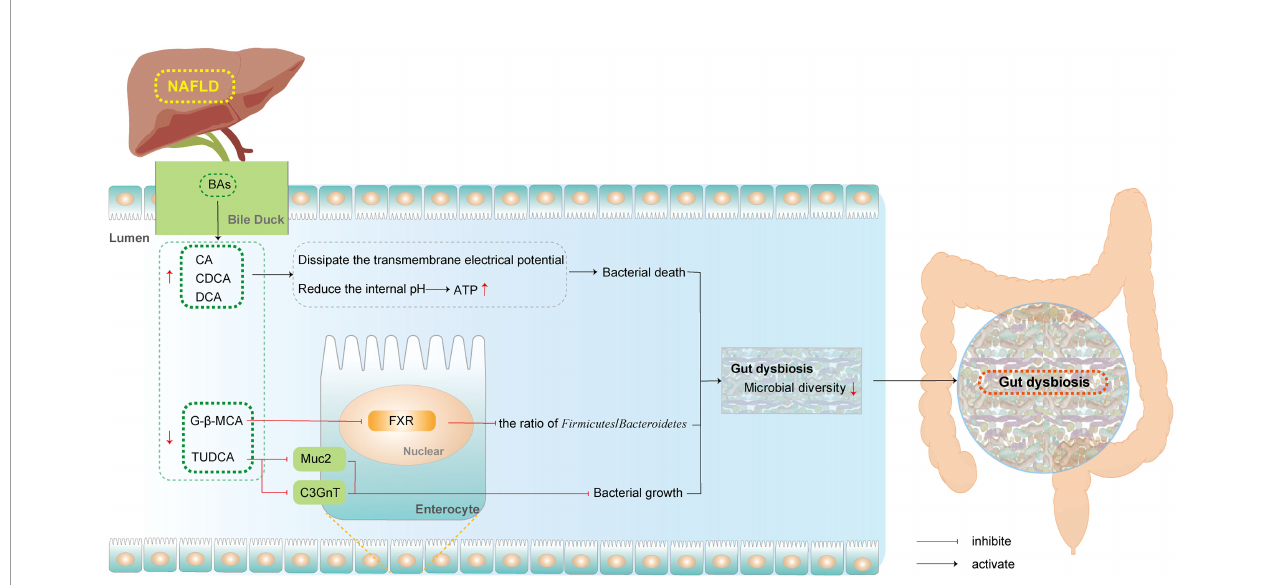
FIGURE 2 | BAs in fl uence GM in NAFLD. (BAs, bile acids; CA, Cholic acid; CDCA, Chenodeoxycholic acid; C3GnT, Core 3 O-glycan; DCA, deoxycholic acid; FXR, farnesoid X receptor; Muc2, mucin 2; NAFLD, non-alcoholic fatty liver disease; G- b -MCA, glycine- b -muricholic acid; TUDCA,